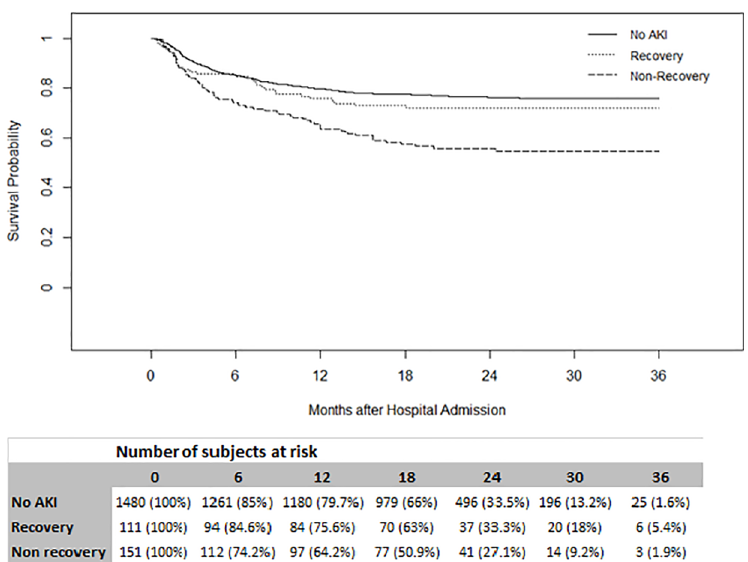
Fig 2. Kaplan-Meier survival curves stratified by recovery status. The three groups are significantly different overall, p < 0.001 (Peto-Peto-Prentice test).